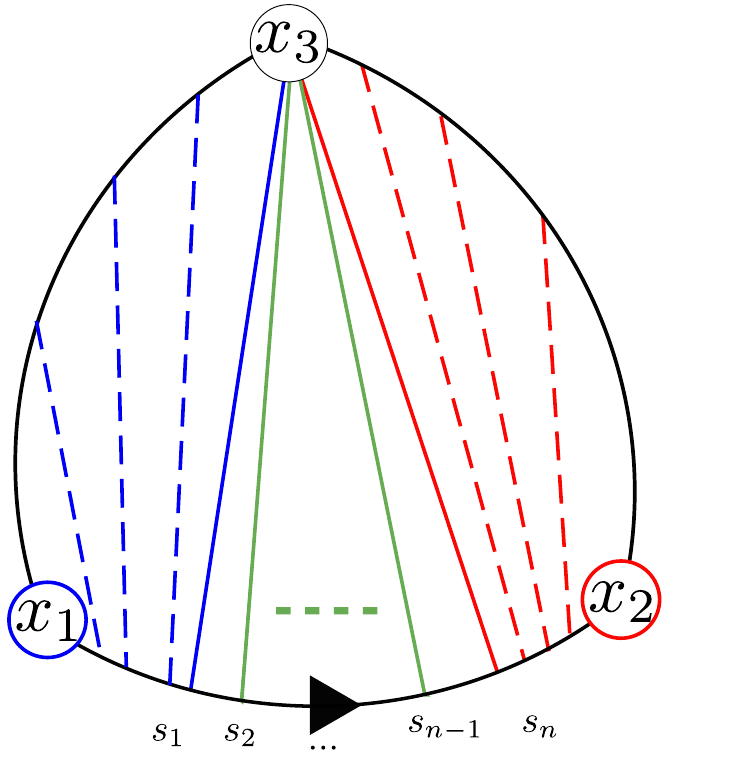
Figure 3 . Leading order diagram for the cusp with insertions. Blue and red dashed lines are resummed up to the blue and red solid lines respectively, and the solid lines (one red, one blue and n (cid:0) 2 green) are the propagators between the light cusp 3 and the arc opposite